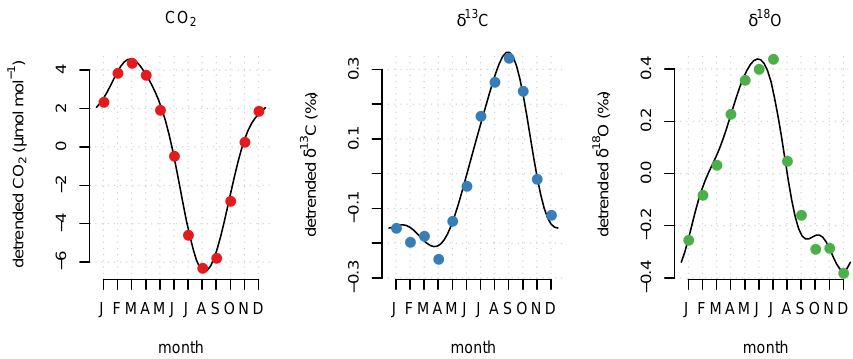
Fig. 7. Mean seasonal cycles from detrended and monthly bin-averaged data (points) and the annual harmonic part of the smoothed curve fit (lines). Error bars of the monthly averaged data are smaller than the plot symbols.